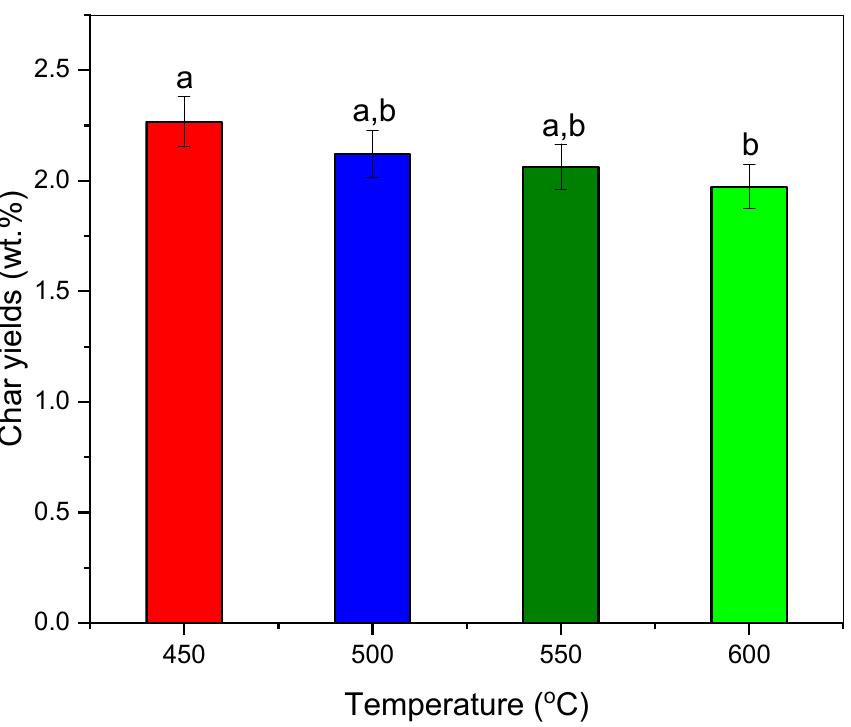
Figure 2. Char yields (wt.%) at different pyrolytic temperatures (°C). Take note that a,b values with different letters in the same column are significantly different ( p < 0.05).